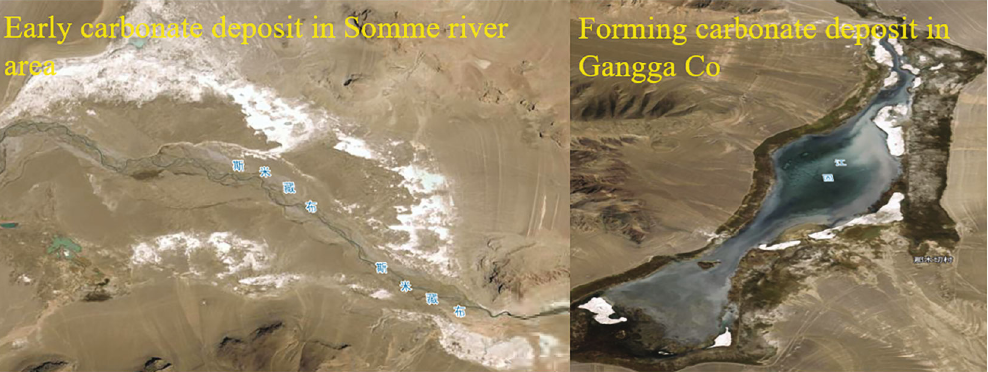
Figure 6: Carbonate deposits of Lakkor Co area on Google Earth.